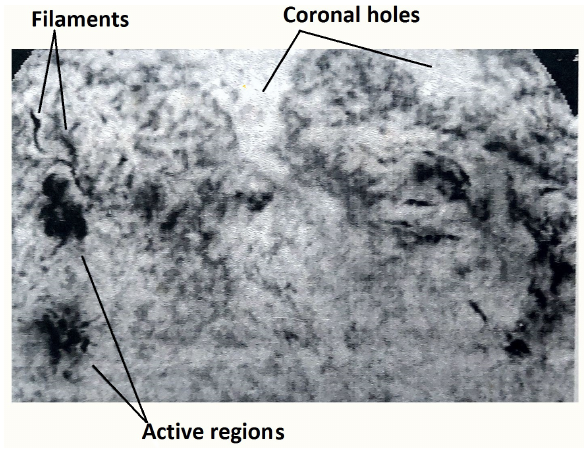
Figure 2. Solar structures on the image of the Sun obtained in the He I line